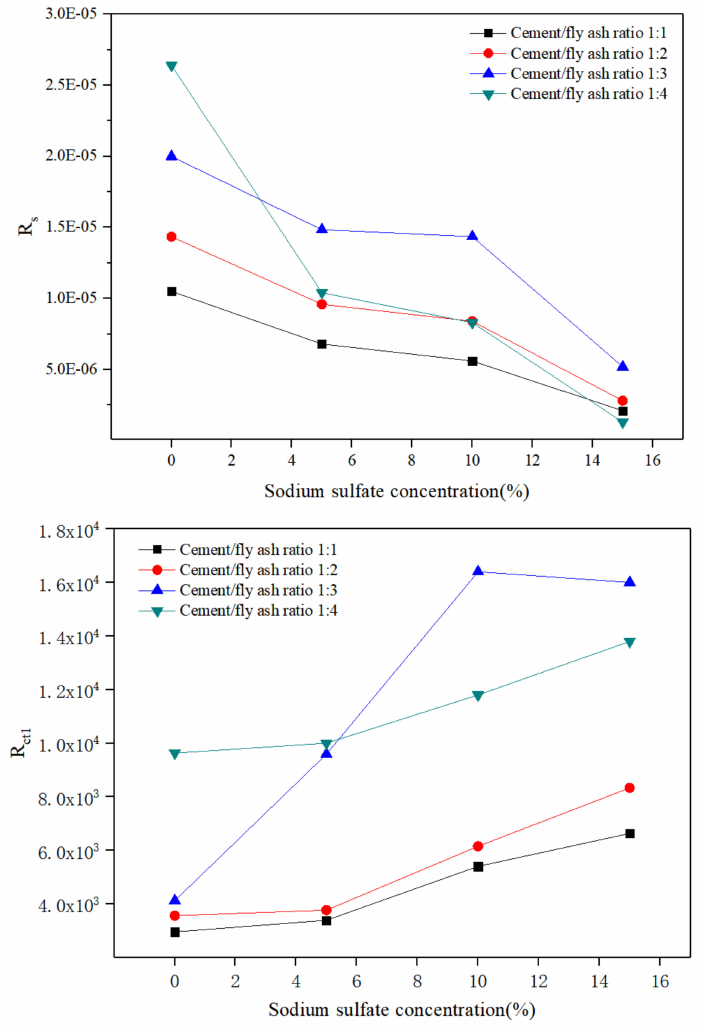
Figure 10. E ff ect of sodium sulphate concentration on